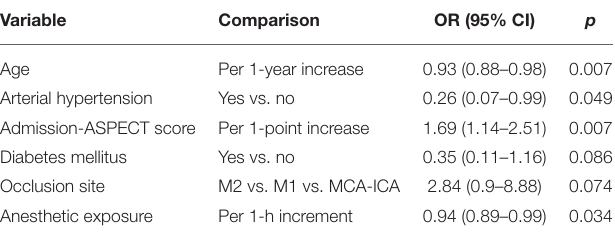
TABLE 3 | Associations between baseline and clinical variables and 90-days favorable functional outcome on stepwise backward Wald logistic regression analysis*.